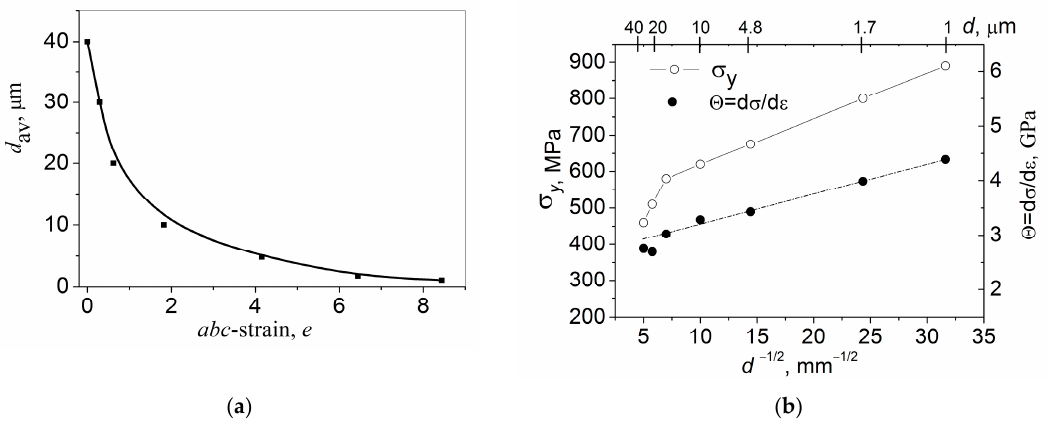
Figure 6. ( a ) Average grain–subgrain size d av versus true strain e in abc pressing; ( b ) Yield stress σ y and strain hardening coefficient θ versus d av − ½.